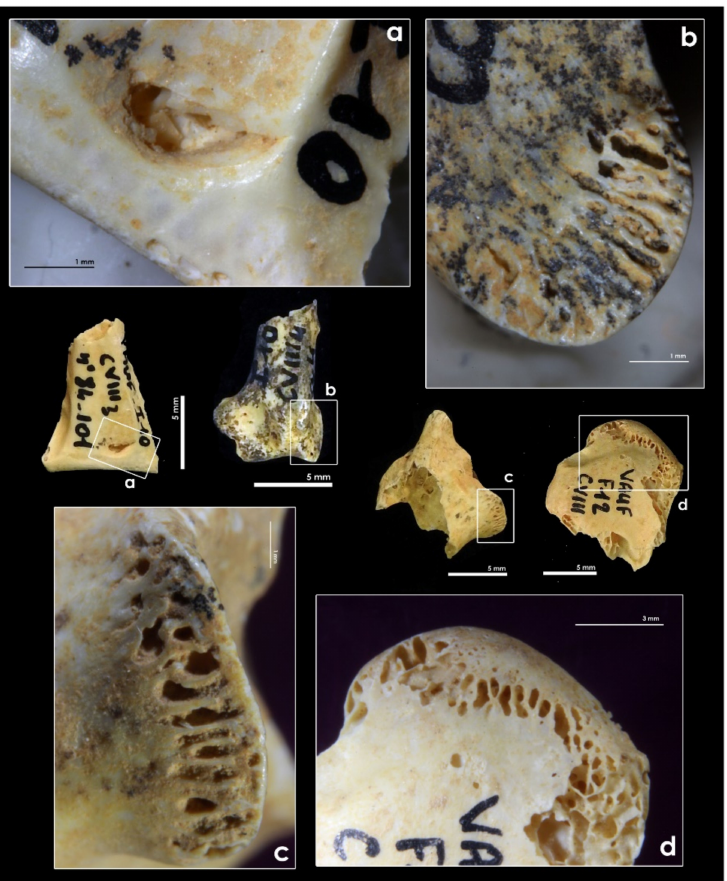
Figure 3. Non-human alterations observed at Grotte Vaufrey layer VIII: pit ( a ) and digestive damage ( b – d ). ( a ) Left sternal coracoid of P. graculus . ( b ) Left distal medium-sized Corvidae ulna . ( c ) Right proximal ulna of C. corone/frugilegus . ( d ) Left humerus of P. graculus